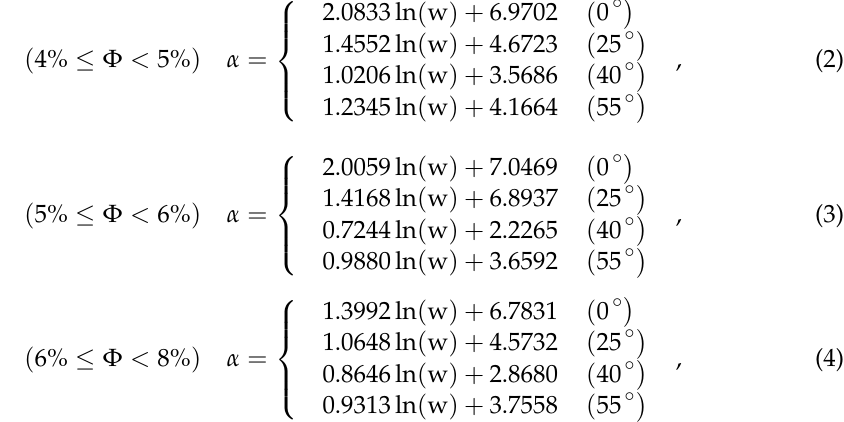
y = 2 . 0833 l n ( x ) + 6 . 9702 R ² = 0 . 849